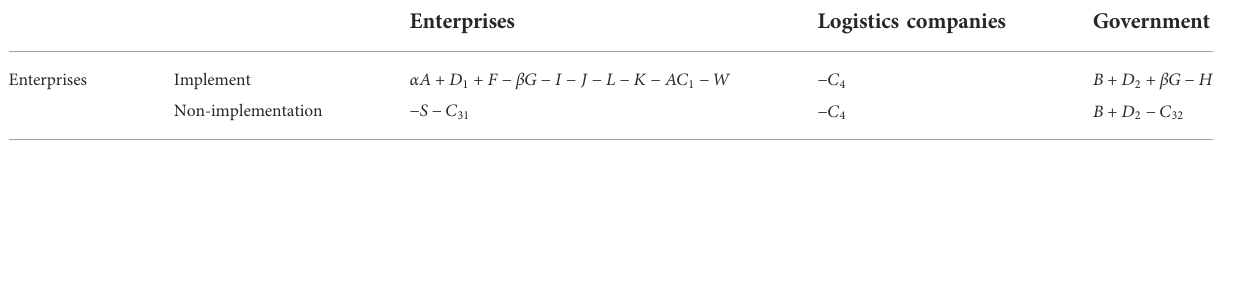
TABLE 4 Game matrix with government participation but no logistics company